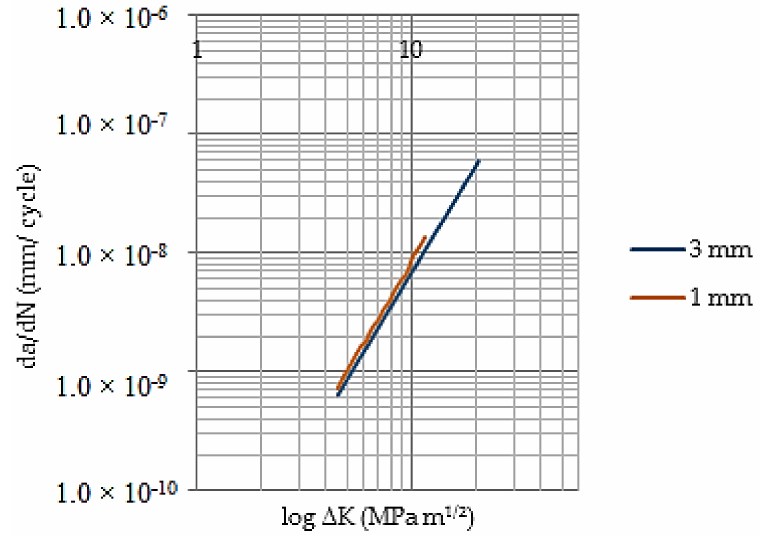
Figure 14. Propagation crack rate versus variation range for SIF.